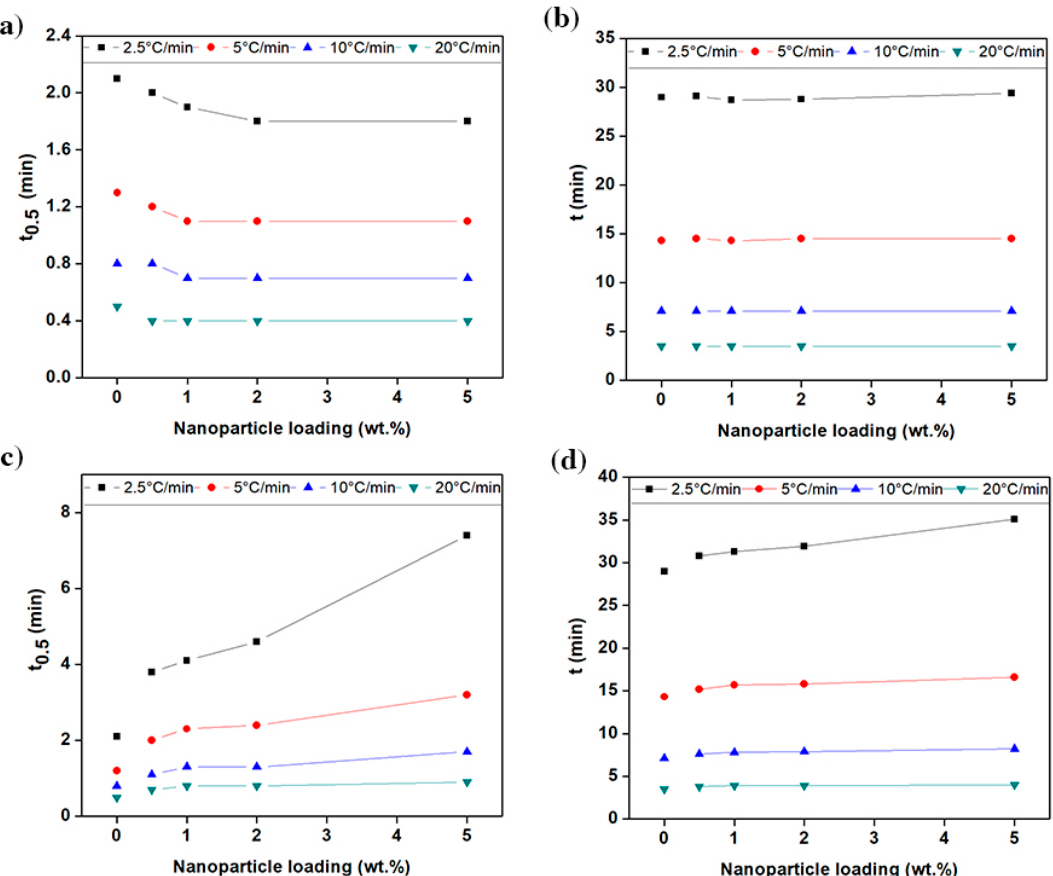
Figure 5. The influence of ( a , b ) carbon black and ( c , d ) graphene fillers on t 0.5 and overall crystallisation t of the multimodal-HDPE at different cooling rates.